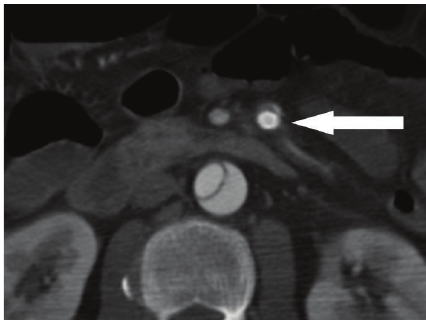
Figure 5: Contrast enhancement in the internal SMA stent was well maintained on contrast-enhanced CT at two weeks after the